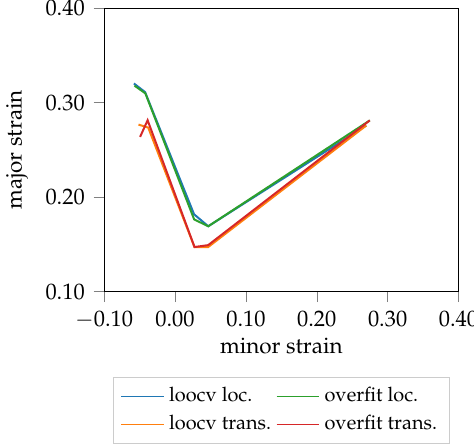
Figure 8. FLC candidates of